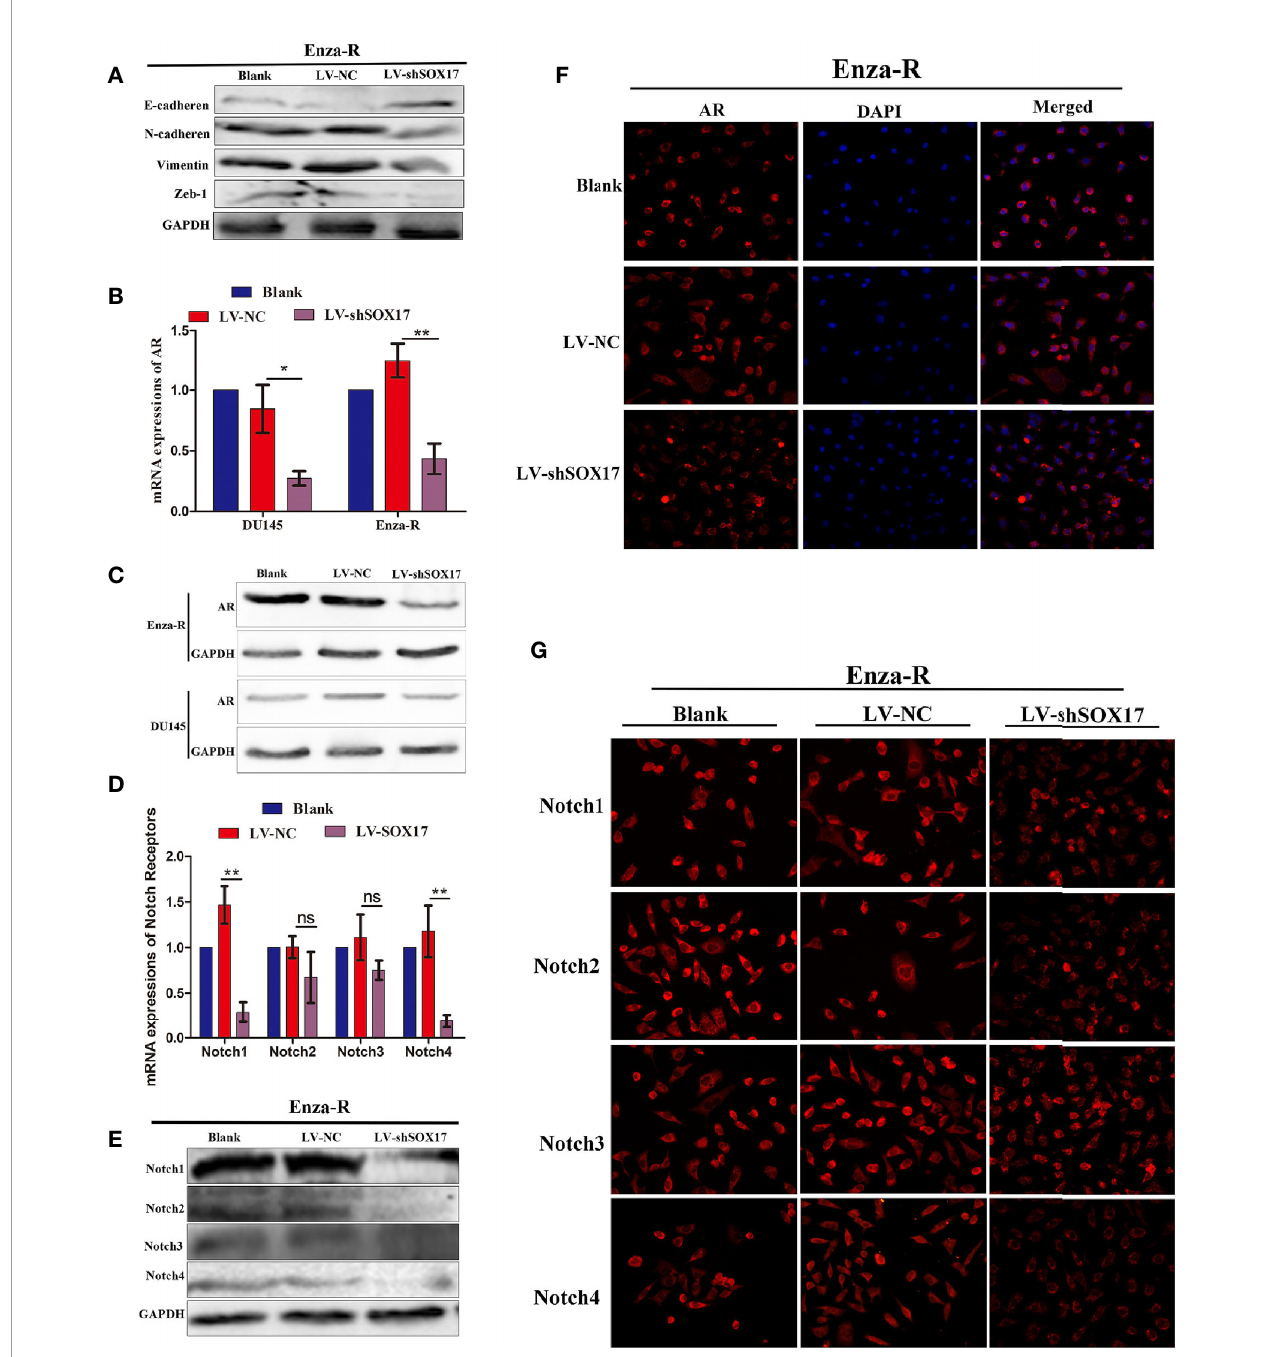
FIGURE 4 | Knocking down SOX17 reducing the expression of EMT related proteins, AR, Notch receptor members. (A) Expression of E-cadherin, N-cadherin, Vimentin and Zeb-1 in Enza-R cells, infected with LV-NC or LV-shSOX17, was examined by Western blot assay. GAPDH served as a loading control. (B – D) The expression of AR in Enza-R or/and DU145 cells, infected with LV-NC or LV-shSOX17, was evaluated by using RT-PCR, Western blot and Immuno fl uorescence (magni fi cation, ×200) assay. GAPDH served as a loading control. (E – G) Expression of Notch1, Notch2, Notch3, Notch4 were investigated by using RT-PCR, Western blot and Immuno fl uorescence (magni fi cation, ×200) assay in Enza-R cells treated with LV ‐ NC or LV ‐ shSOX17, *P < 0.05, **P < 0.01, ns, no signi fi cance; AR, androgen receptor; Enza-R, enzalutamide-resistant LNCaP